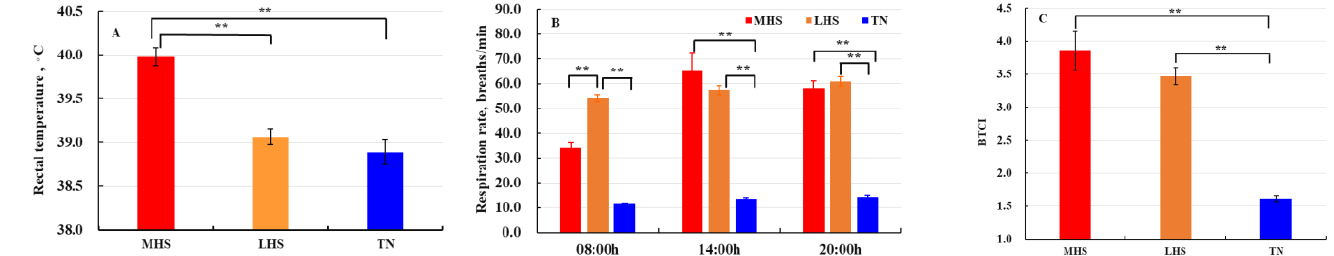
Figure 2. Rectal temperature ( A ), respiration rate ( B ), and Benezra’s thermal comfort index (BTCI) ( C ) of yaks under TN, LHS, and MHS conditions. TN = Thermal-neutral, LHS = Light heat stress, and MHS = Medium heat stress. ** p < 0.01.